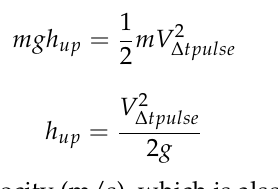
where F u and F o are considered the forces produced by pressures under and over the block (kN), and are produced because of the dynamic pressure in the pool bottom; G b is the submerged weight of block (kN), which is determined by using Equation (29); and F sh is the shear force (kN). Shear force ( F sh ) is considered zero because it acts in a direction parallel to a surface. This variable is zero for a cubic block. Time integral ( dt ) is in seconds, taken over the ∆ t period ( ∆ t is the period in which positive differences exist in forces produced by pressures over and under the block), and is determined by Equation (34). The block mass m s is in kilograms and determined by Equation